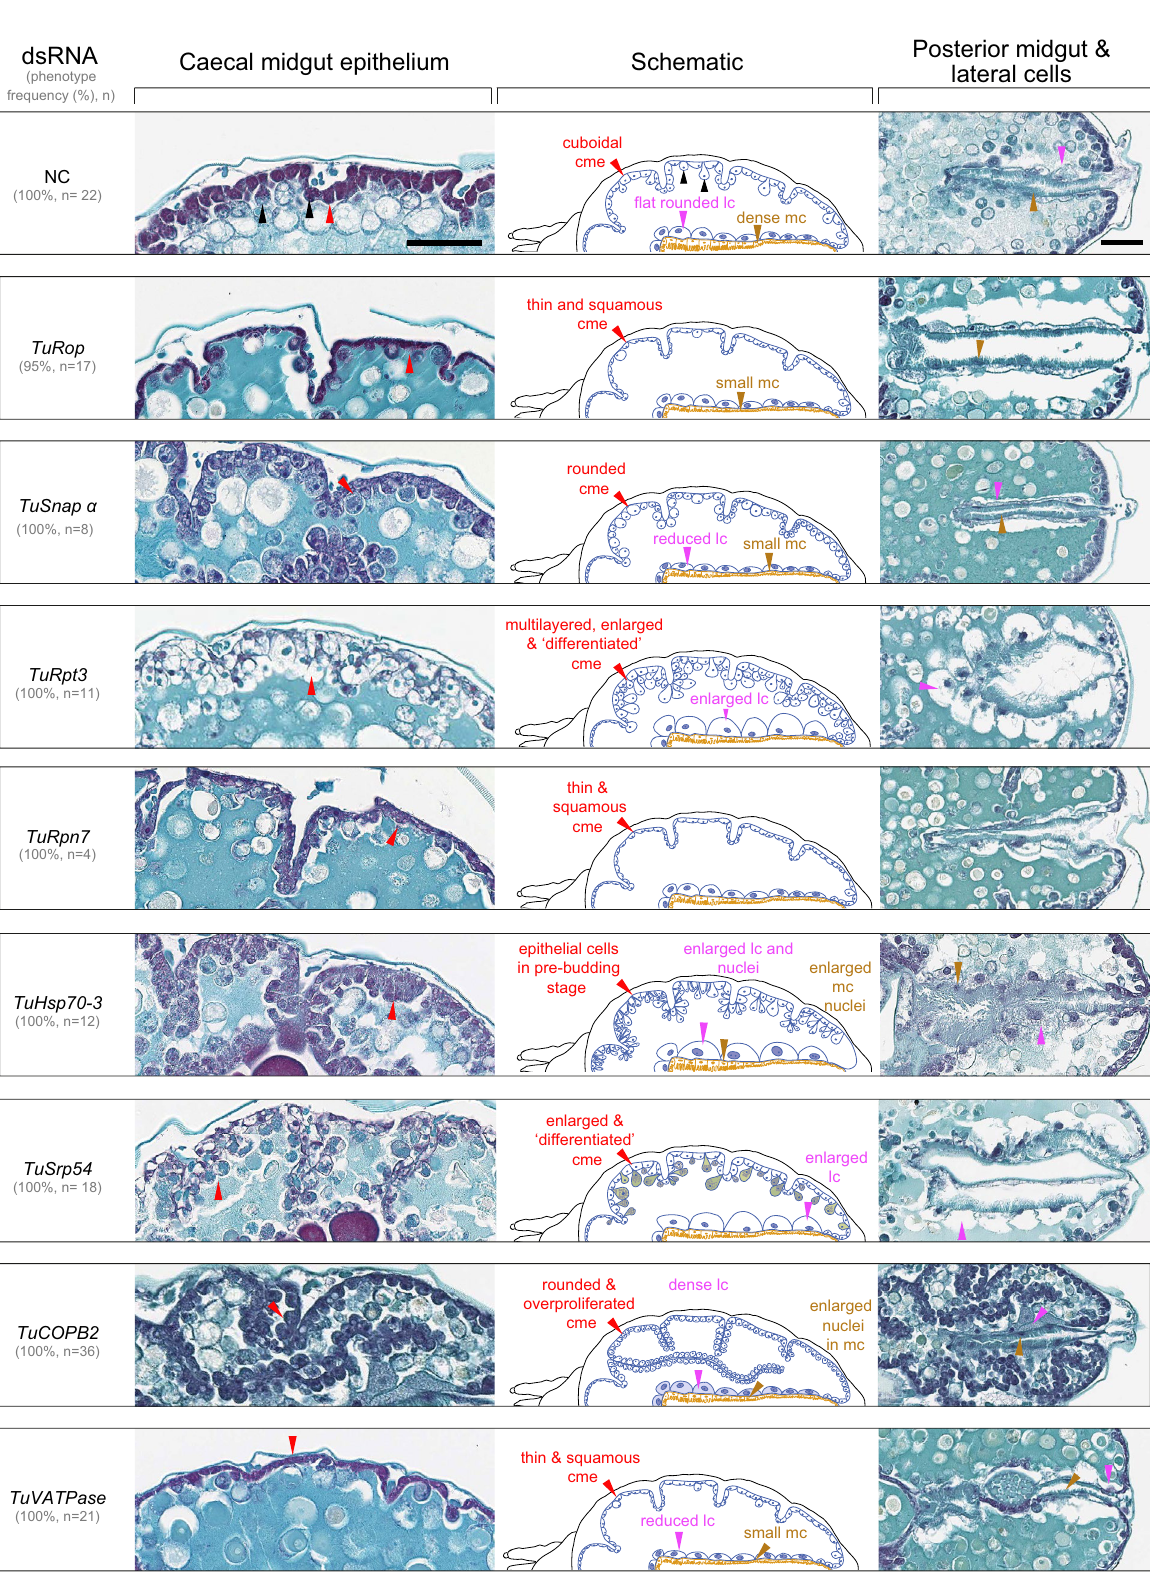
Figure 6. Histological phenotypes of midgut epithelial cells upon dsRNA treatments. Left, details of caecal midgut epithelial cells; right, details of large and posterior midgut cells in mites treated with dsRNAs; middle, schematics illustrating changes of midgut epithelial cells upon dsRNA treatments. Caecal midgut epithelial cells normally consist of cuboidal and densely stained cells (red arrowhead), rounded cells and enlarged cells that protrude into the caecal lumen (black arrowheads). magenta arrowhead, large cells (lc); brown arrowhead, microvilli cells in the posterior midgut. Scale bar: 50